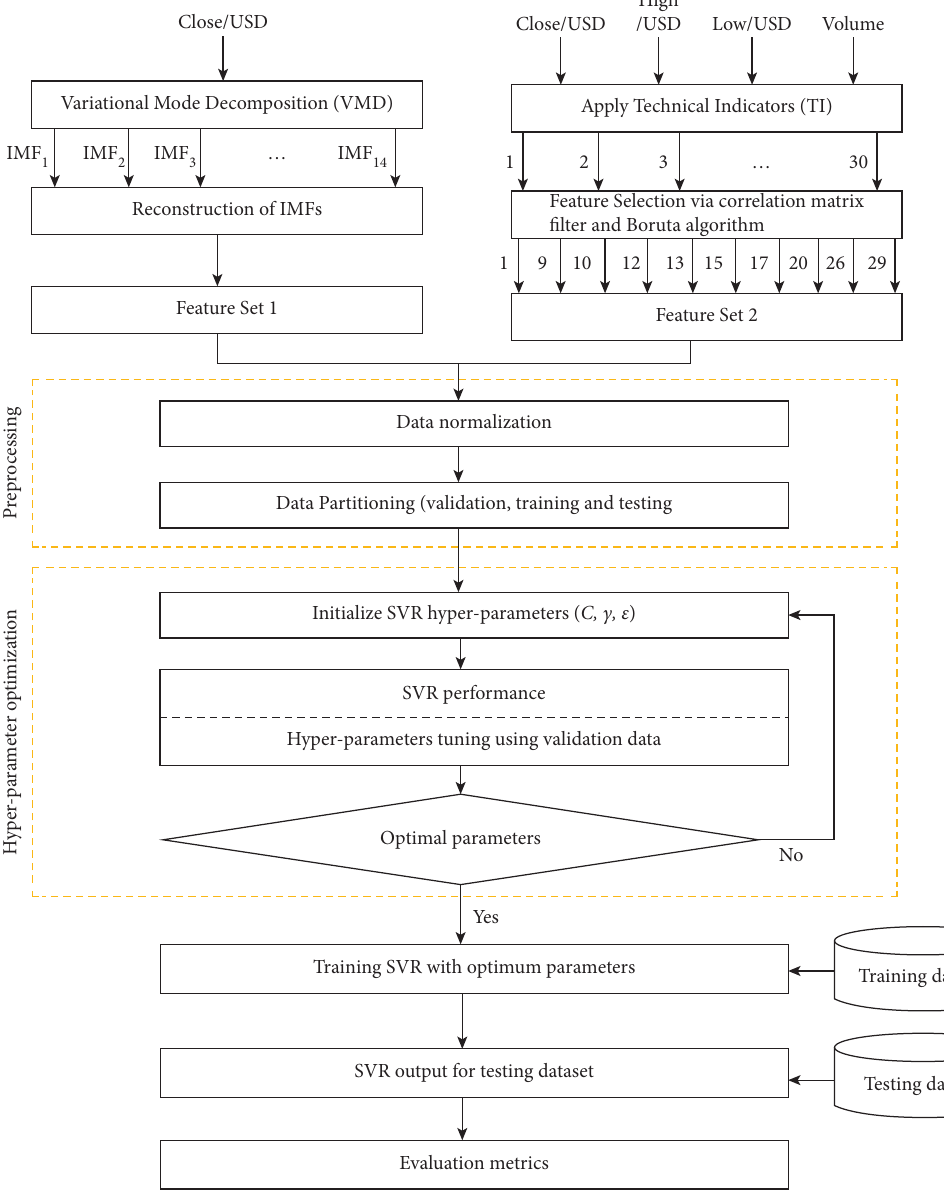
Figure 2: The structure of the proposed SVR-TI-rVMF